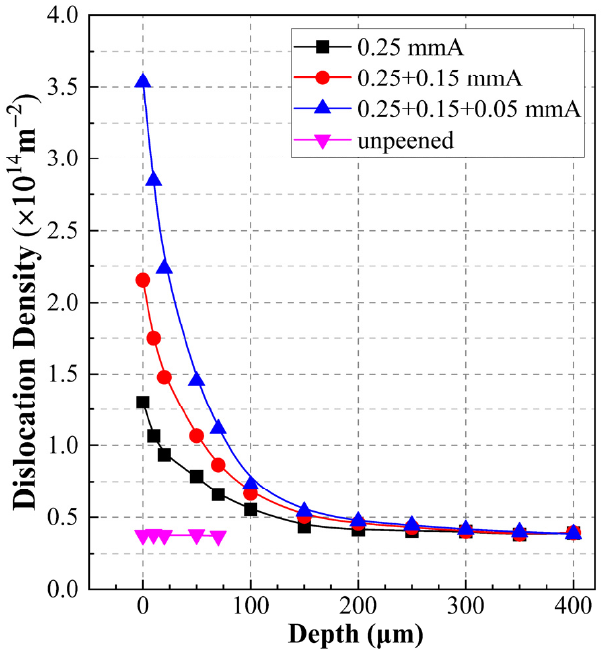
Figure 7. Dislocation density − depth distribution after multiple shot peening.